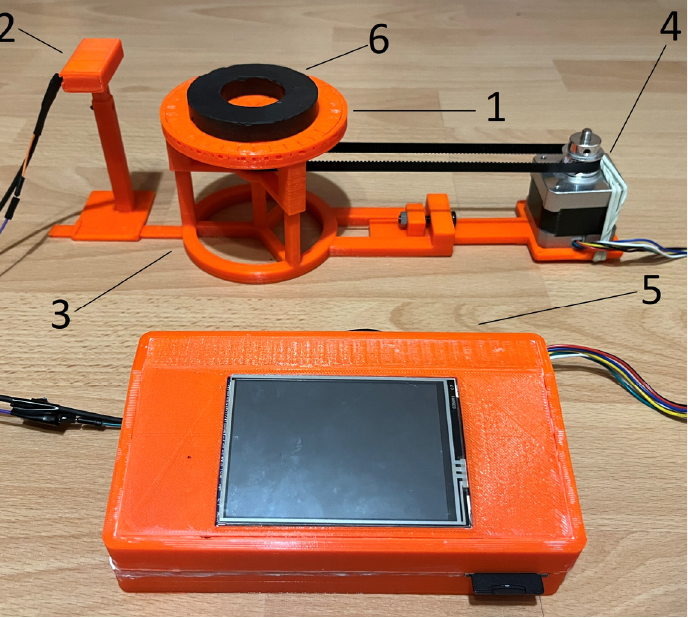
Figure 2. The measuring stand with individual elements distinguished: the rotating stand (1), the magnetometer on an adjustable holder (2), the ruler marking the distance from the center of the rotating base (3), the stepper motor with a drive belt (4), the control module with a display (5), and the tested toroidal magnet (6).